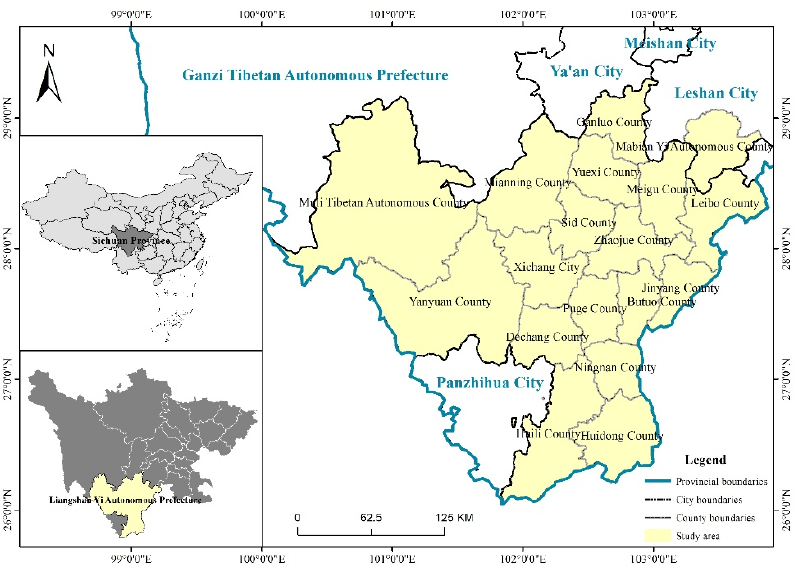
Figure 1. Location of the study